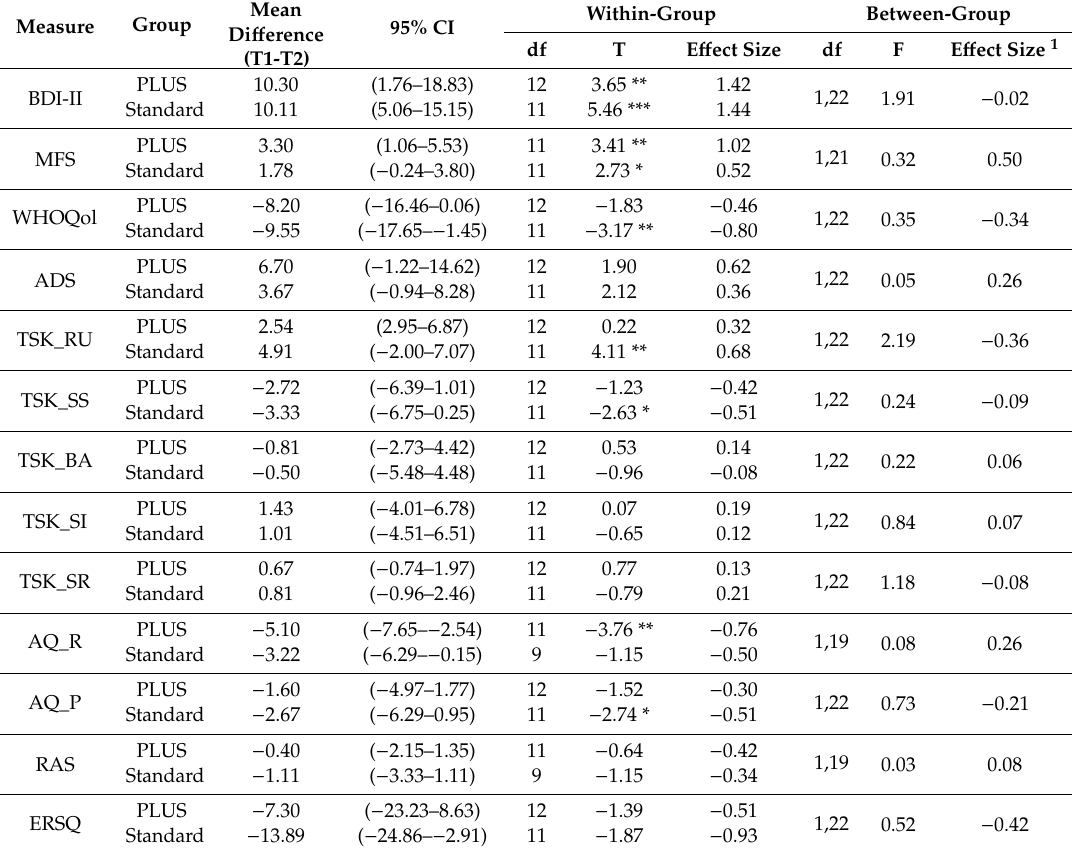
Table 5. Results of analyses of covariance at follow-up (T3) controlled for baseline (T1) and within- and between-group e ff ect sizes at